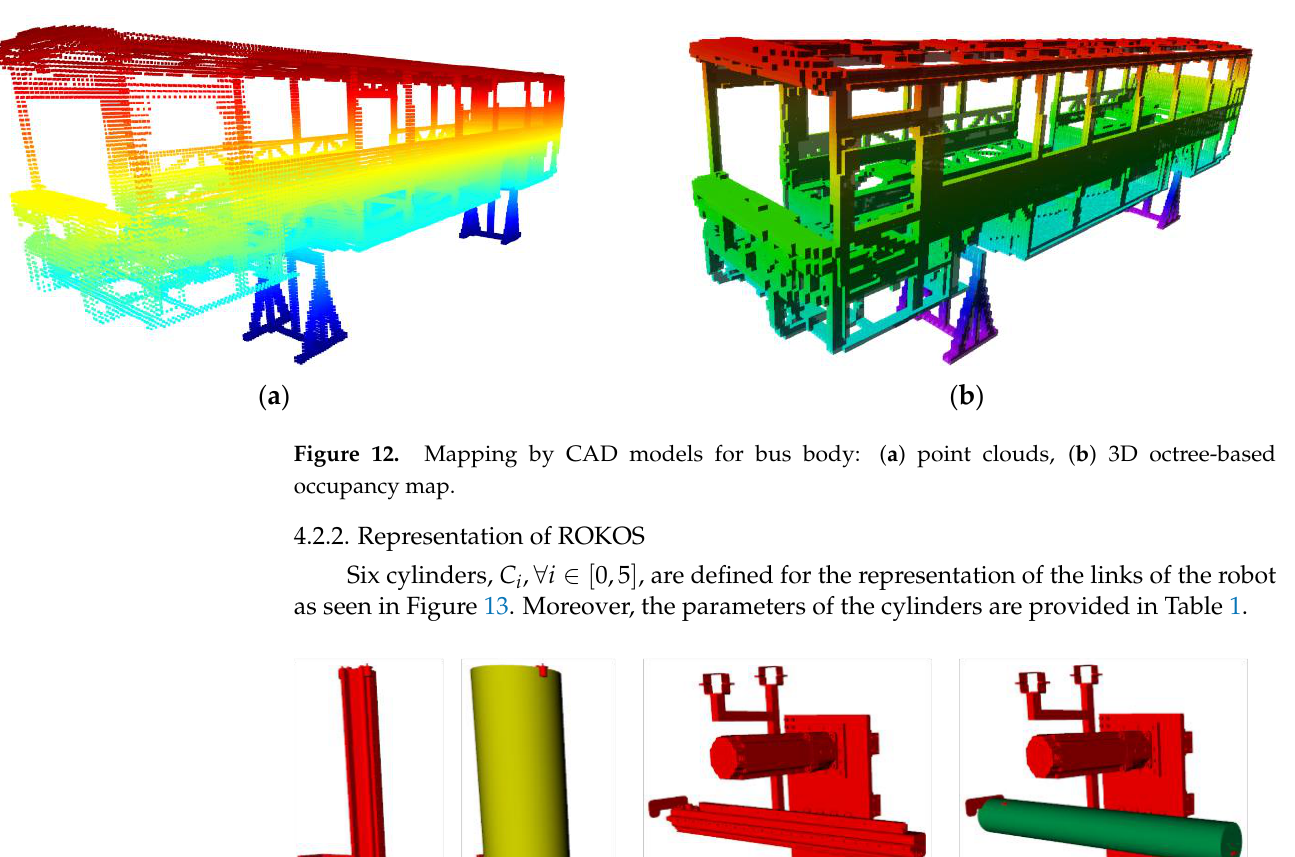
Figure 11. Flow diagram for mapping by CAD models.